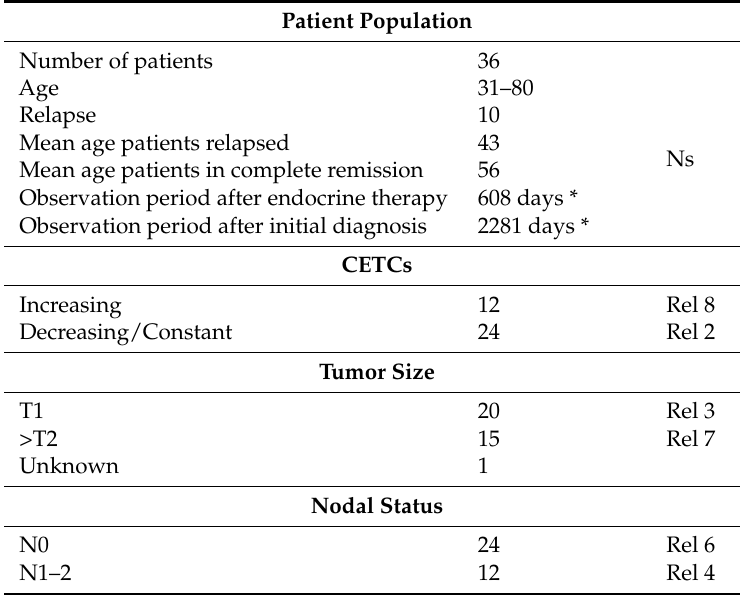
Table 1. Patient